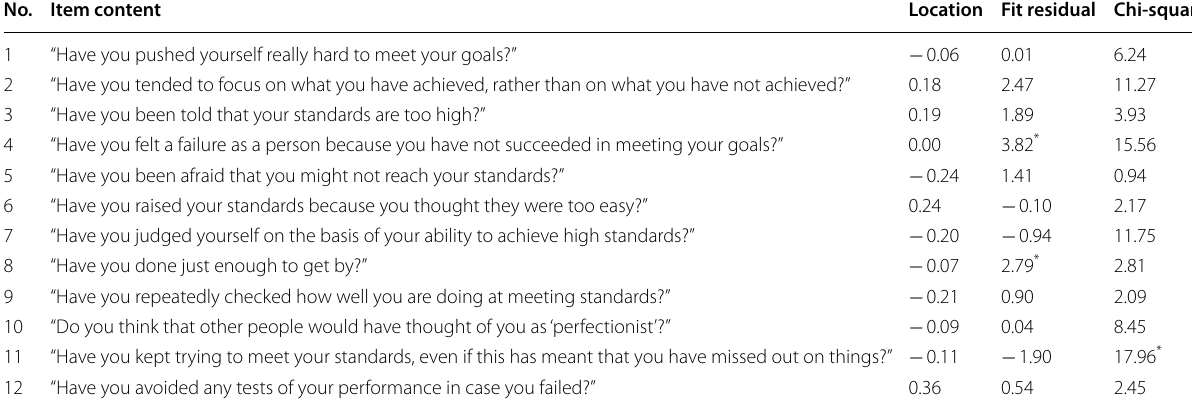
* Significant ( p < 0.01, Bonferroni adjusted) misfit to the Rasch